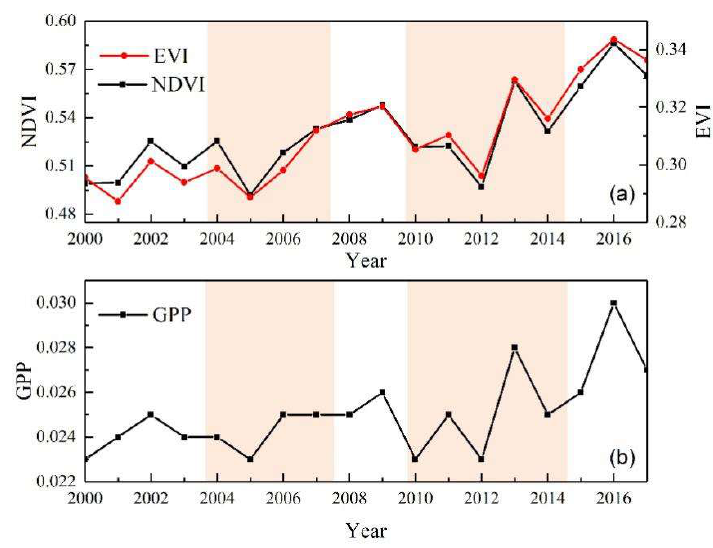
Figure 6. Variations of vegetation indices and indicator of carbon cycle: ( a ) Normalized Difference Vegetation Index (NDVI) and Enhanced Vegetation Index (EVI), ( b ) Gross Primary Productivity (GPP).